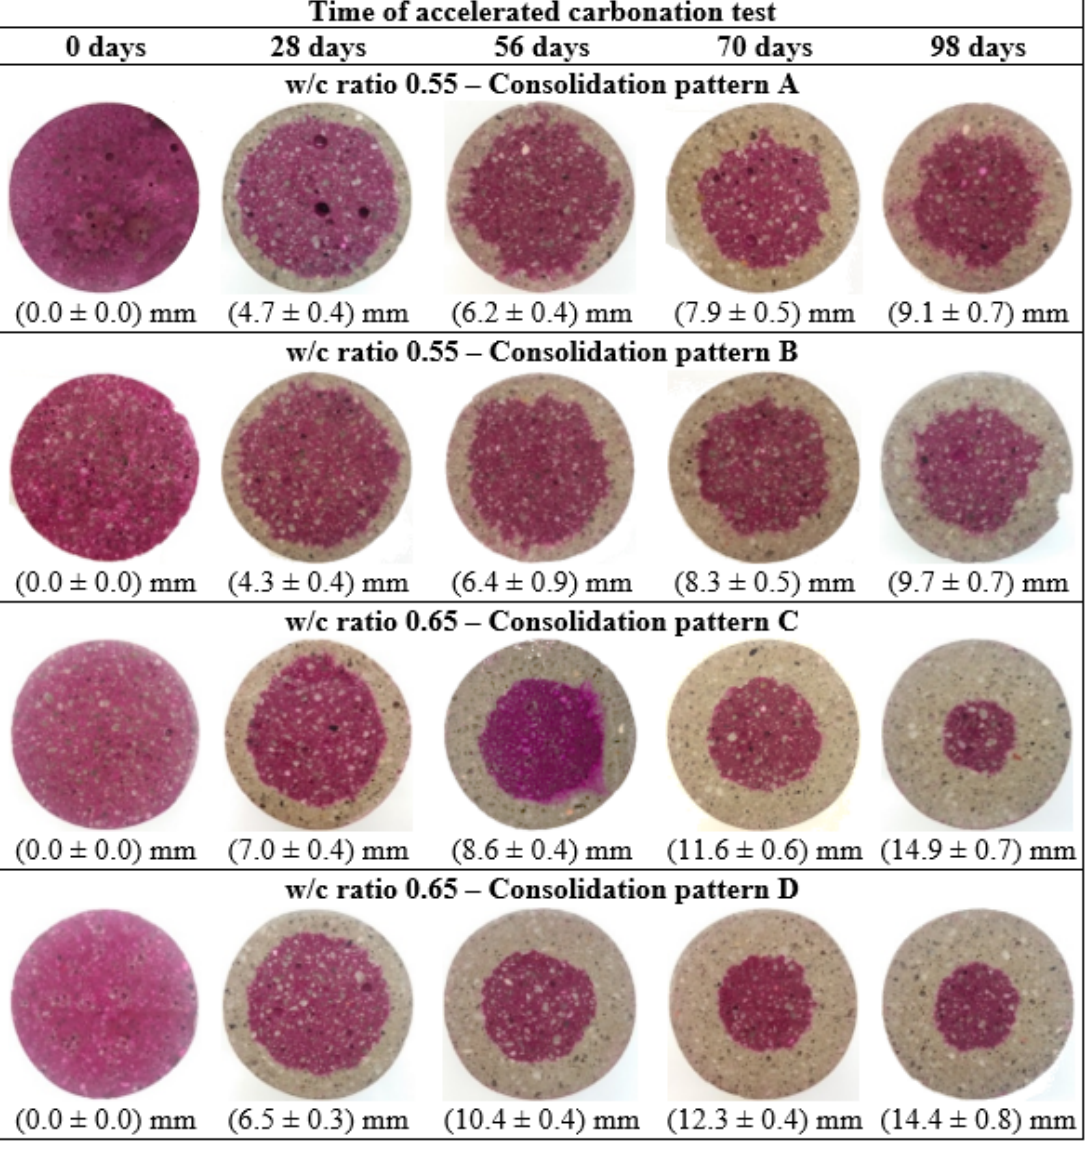
Figure 4. Monitoring the progress of the carbonation front by colorimetric pH